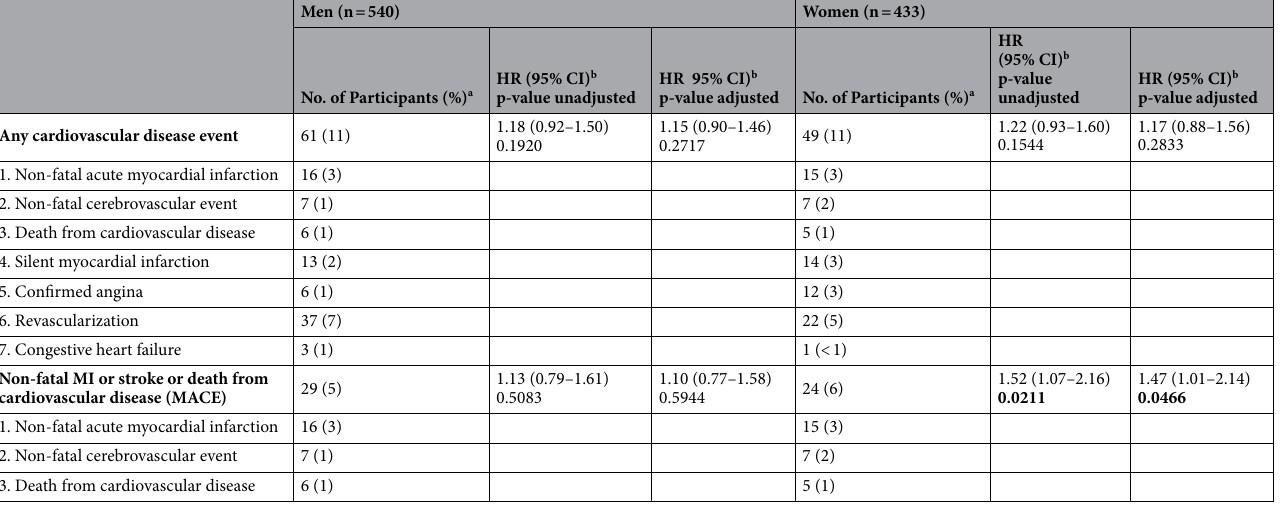
Table 2. Association between SU as a continuous variable and subsequent CVD and MACE events by sex, unadjusted and with minimal adjustment for age and mean DCCT/EDIC HbA1c. a Number of participants with each type of event, regardless of whether or not it is the initial event for that subject (including recurrent events). b Cox proportional hazard regression models minimally adjusted for age and mean DCCT/EDIC HbA1c as fixed covariates at the time of the SU